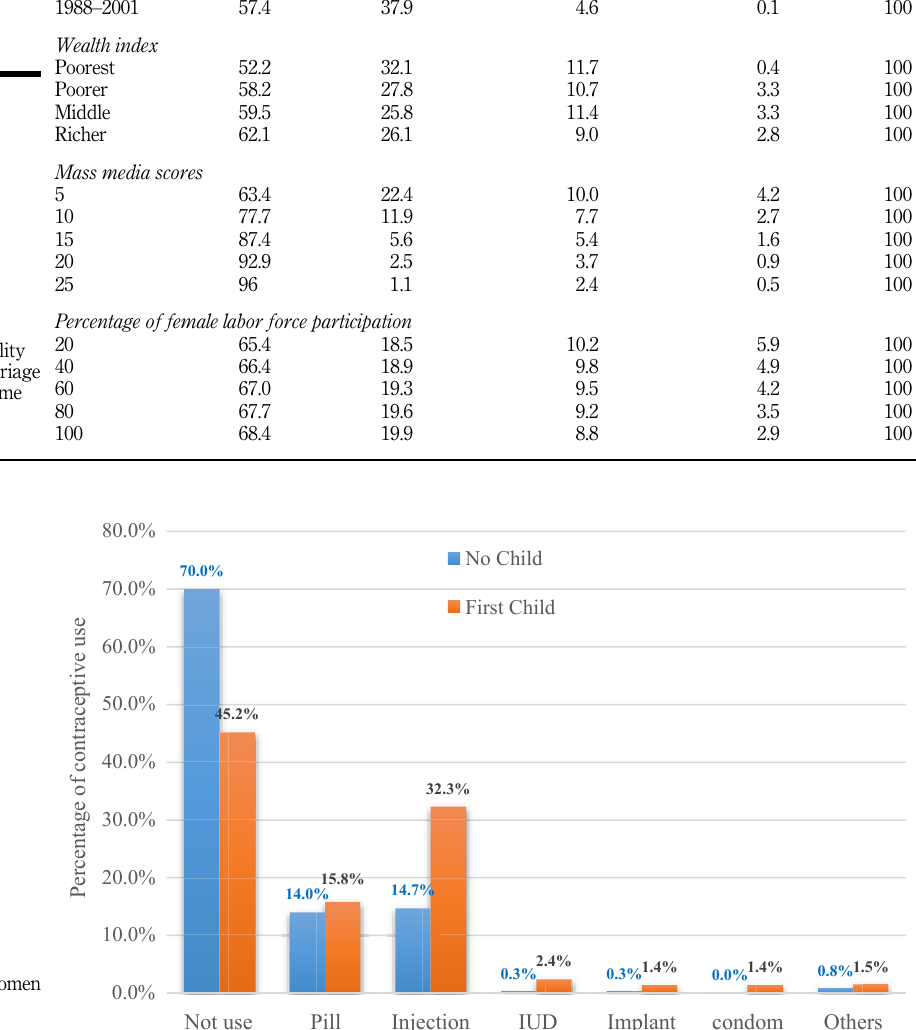
Figure 1. Methods of contraceptive use among married women within five